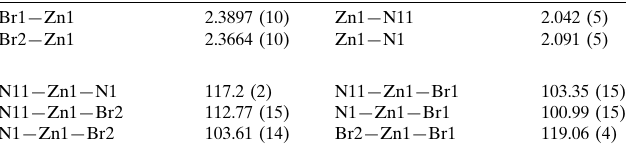
Selected geometric parameters (A˚ , (cid:2)